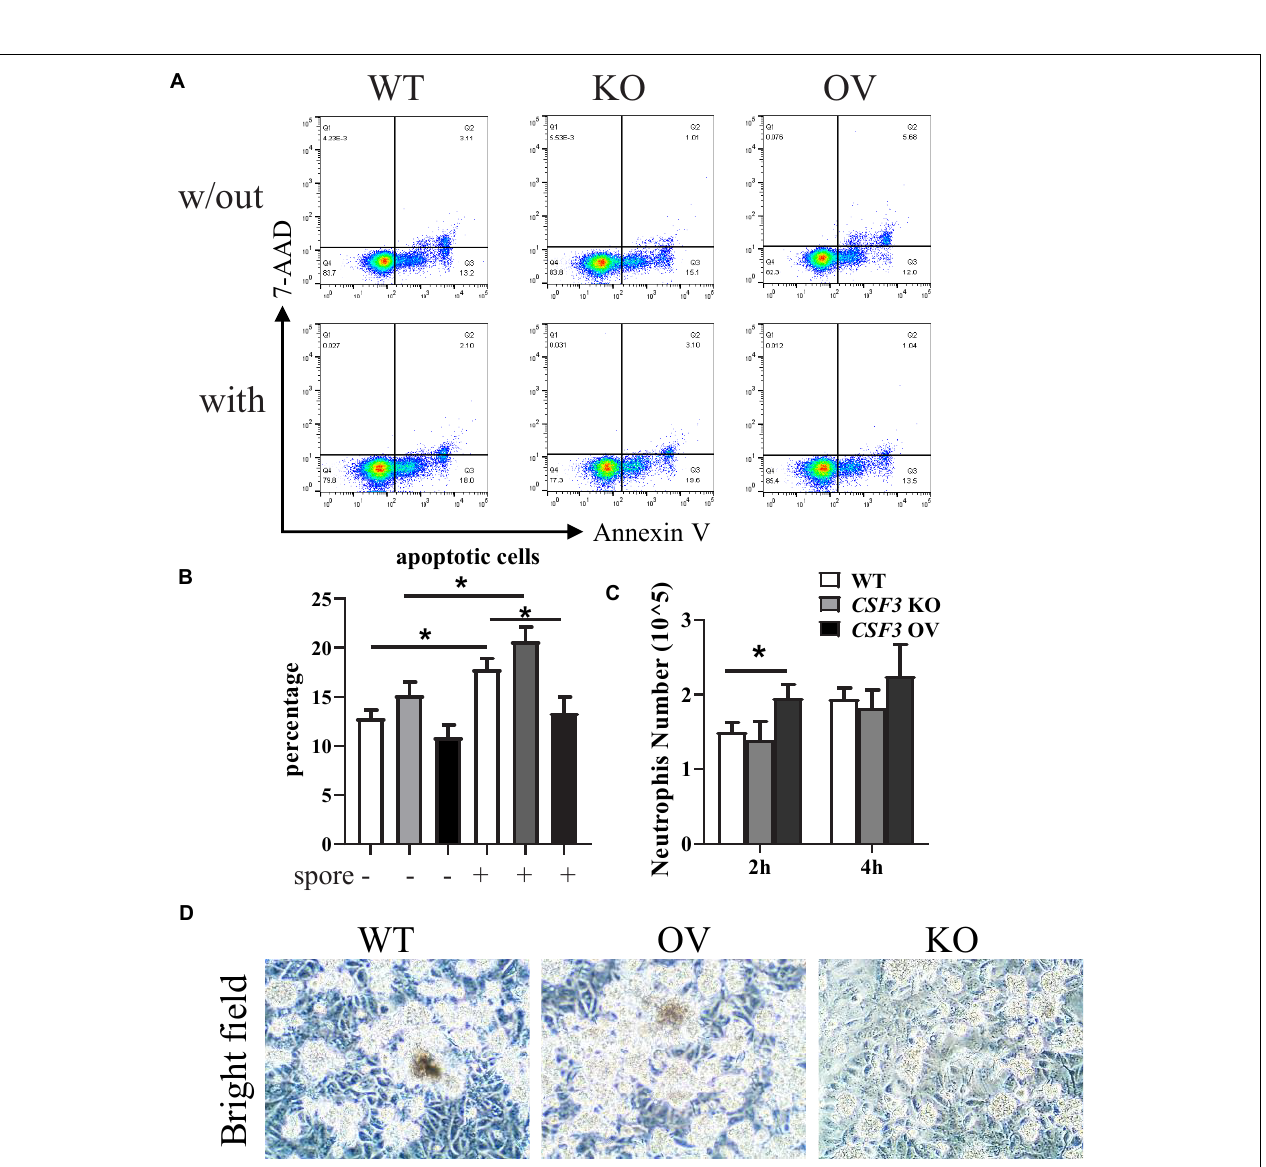
FIGURE 5 | Germination assay of conidia of A. fumigatus co-cultured with HUVECs and neutrophils. HUVECs were seeded in 24-well plate (3 × 10 5 cells per well) overnight before the conidia of A. fumigatus were added to the wells at a cell:spore ratio of 1:2. Neutrophils (2 × 10 5 cells per well) were added 2 h after adding conidia. Representative pictures of conidia were taken at indicated time with WT (A) , CSF3 - / - (B) or CSF3 overexpressing (C) HUVECs and neutrophils. The percentage of germinated conidia was calculated (D) . (E–L) Neutrophils (2 × 10 5 cells per well) were added to a 0.4- µ m Transwell chamber (E,G,I,K) or without the Transwell chamber (F,H,J,L) 2 h after adding conidia, and both the neutrophil cells and supernatant were harvested 6 h later. The gene expression of IL1B (E,F) , IL8 (G,H) , and NOS2 (I,J) were tested by qPCR, and granulocyte-colony-stimulating factor (MPO) was also analyzed (K,L) . WT, wild type HUVEC; KO, CSF3 knockout HUVEC (described in Supplementary Figure 2 ); OV, HUVECs transfected with CSF3 plasmid 48 h before stimulation with conidia. * p < 0.05 compared with WT. Original magnification × 100. Black arrow, germinating conidia.